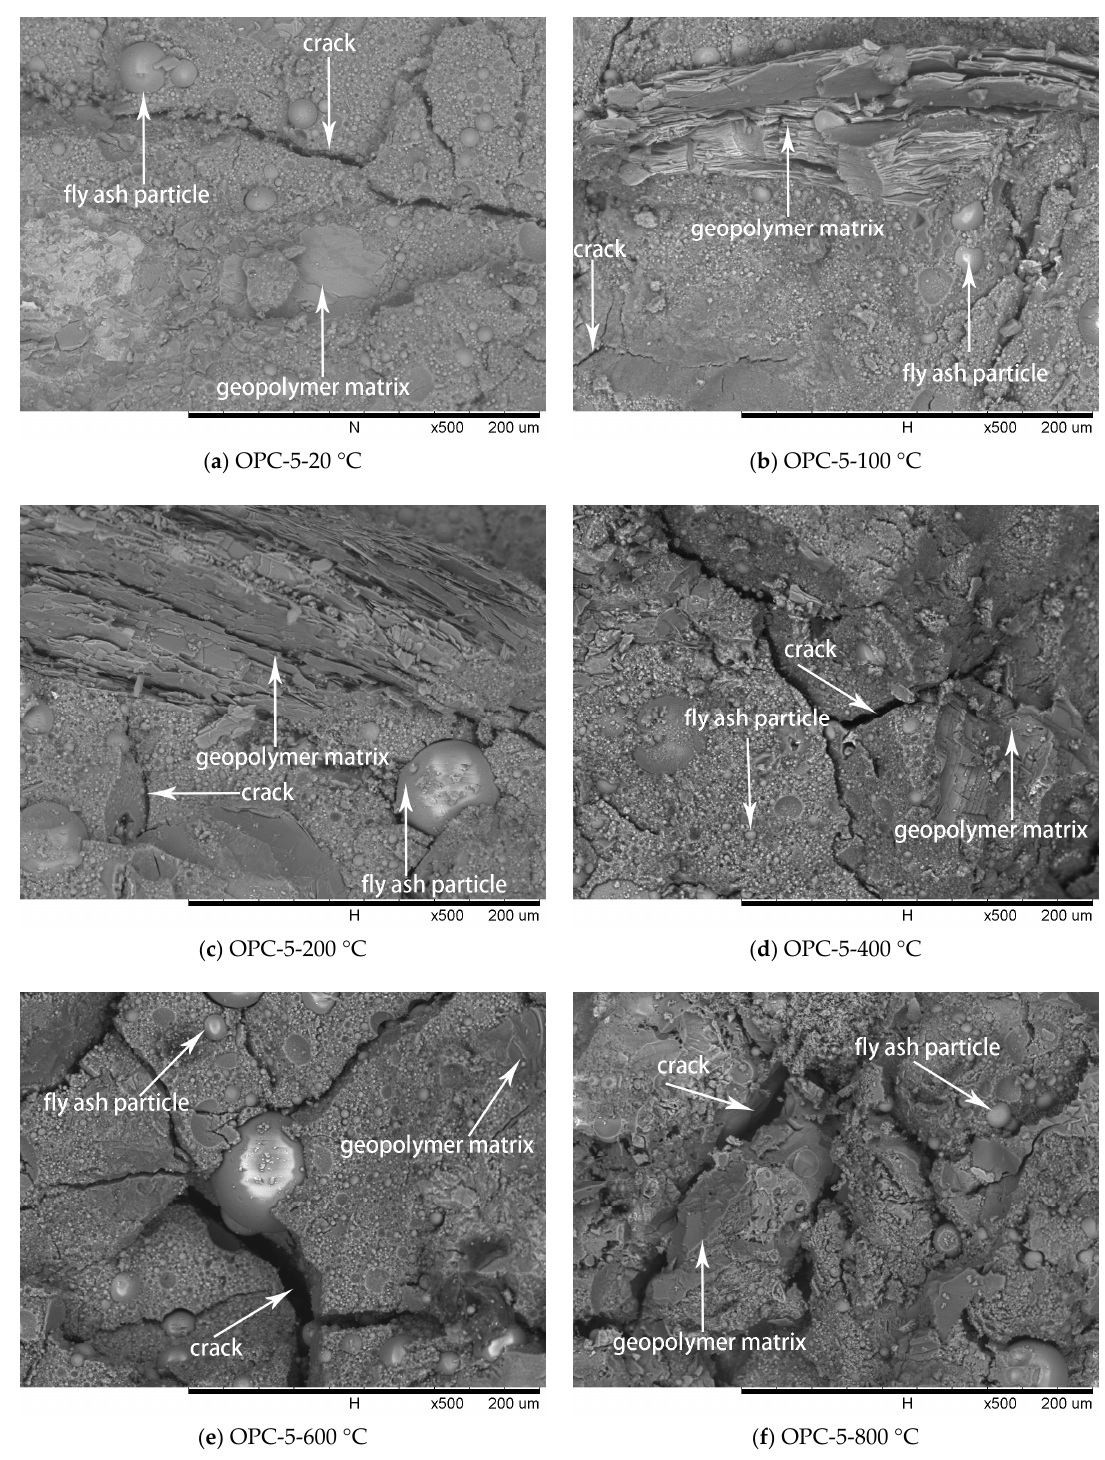
Figure 10. SEM micrographs of OPC-5 series at different temperatures.